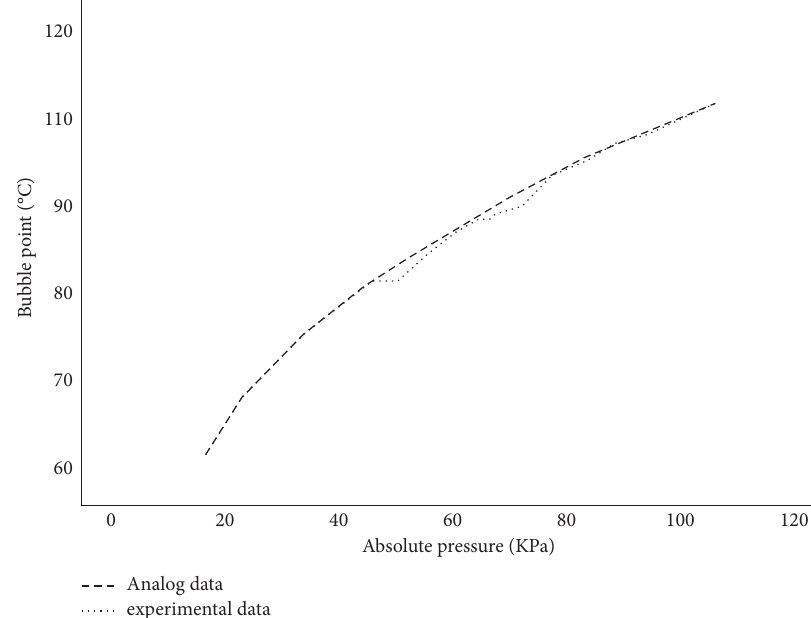
Figure 4: Glycerol saline system bubble simulation data and experimental data. Table 3: Comparison of different steam generation and discharging conditions of the glycerin brine system.